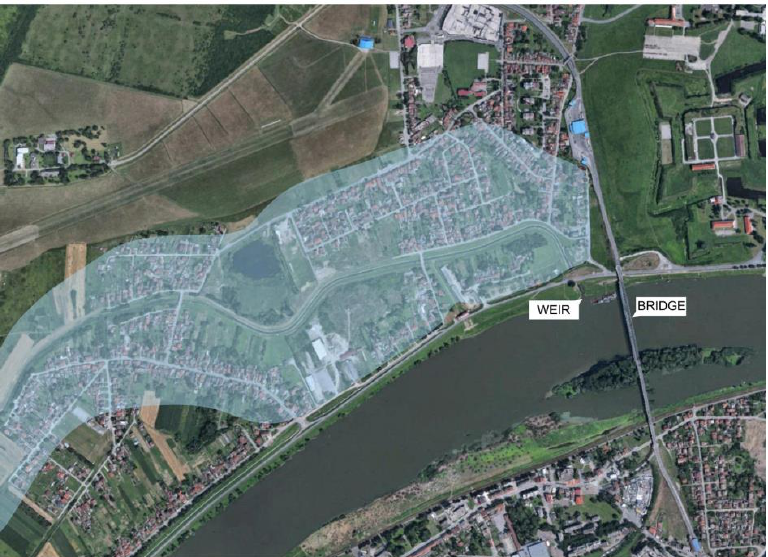
Figure 15. Estimated flooded area due to weir failure in Slavonski Brod.